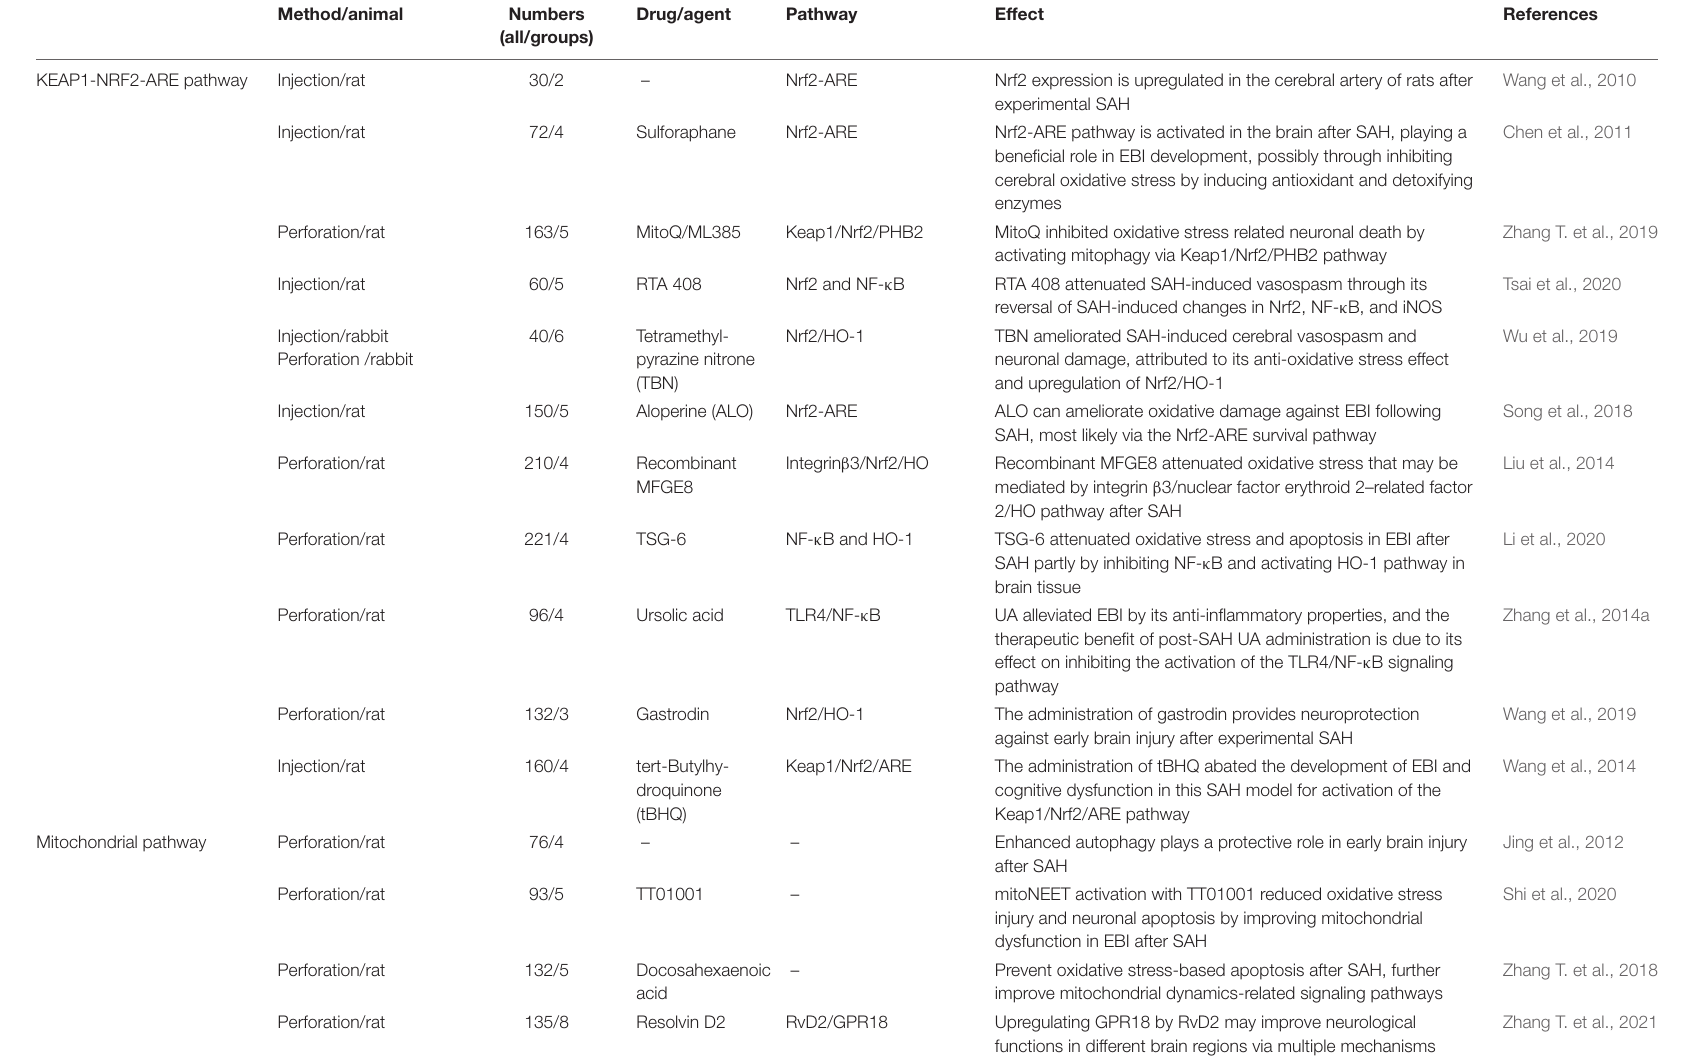
TABLE 1 | Clinical and experimental studies overview of OS in EBI after